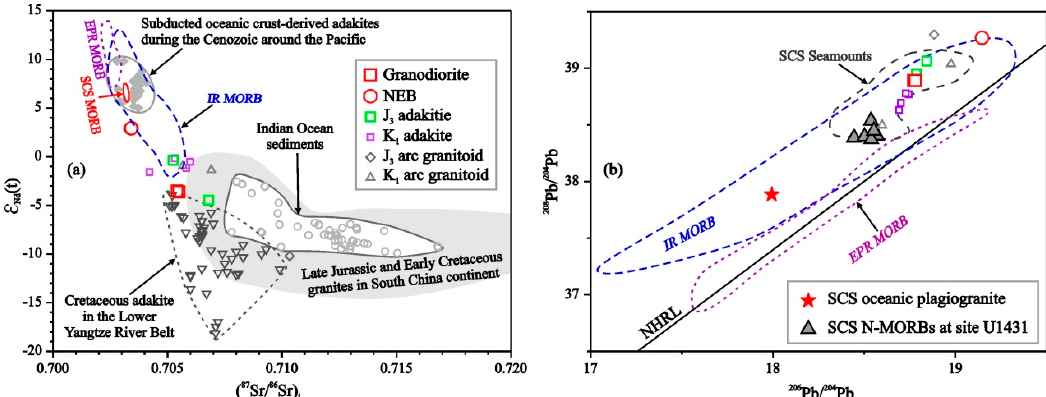
Figure 10. ( a ) ε Nd (t) versus initial 87 Sr/ 86 Sr and ( b ) 208 Pb/ 204 Pb versus 206 Pb/ 204 Pb diagrams for the granodiorites and NEBs from the Xiaozhenzhu Seamount near the Zhongnan Fault in the SCS. The sources of data for comparison with the data of the present study are as follows: Mesozoic arc and adakitic granitoids from the SCS [23,60,61]; Late Jurassic and Early Cretaceous granites in South China continent [62]; SCS oceanic plagiogranite [63]; the East Pacific Rise (EPR), SCS, and Indian Ridge (IR) MORB [64]; Cretaceous adakites in the Lower Yangtze River Belt [65]; oceanic-crust-derived adakites subducted around the Pacific during the Cenozoic [66–68]; and Indian Ocean sediments [69–71].